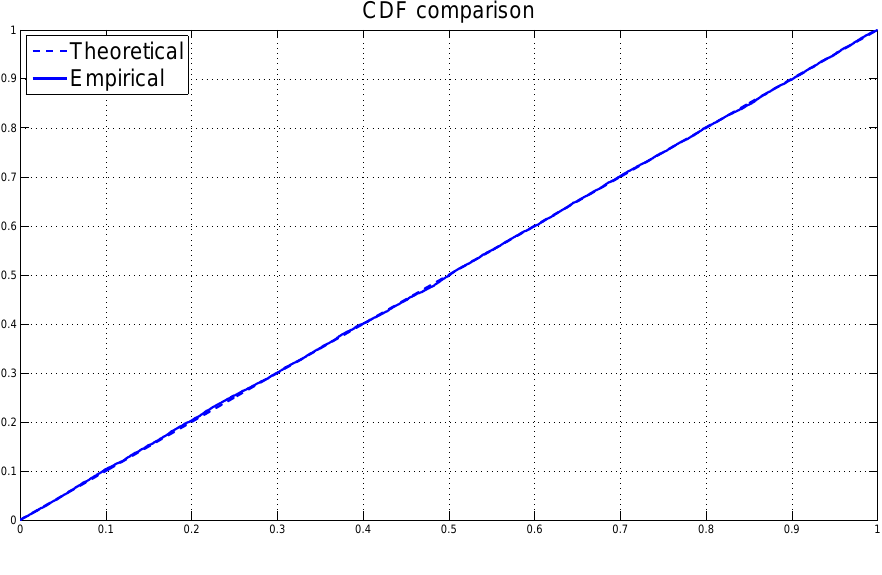
Figure 5. Comparison between the empirical CDF of the PITs and the theoretical CDF of a uniform distribution over the interval [0, 1] based on the TSCD-W model using simulated transaction